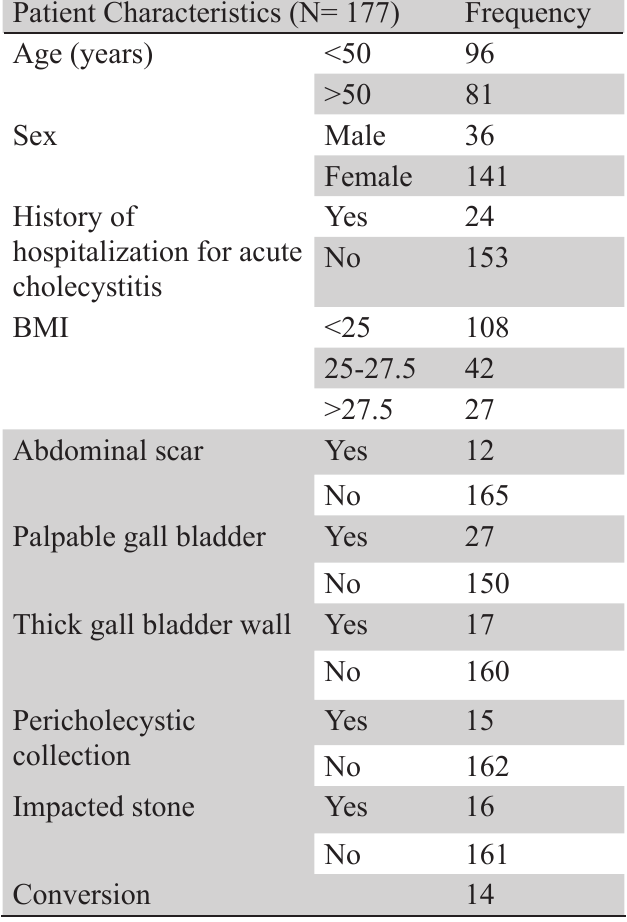
Table 3: Distribution of Parameters.